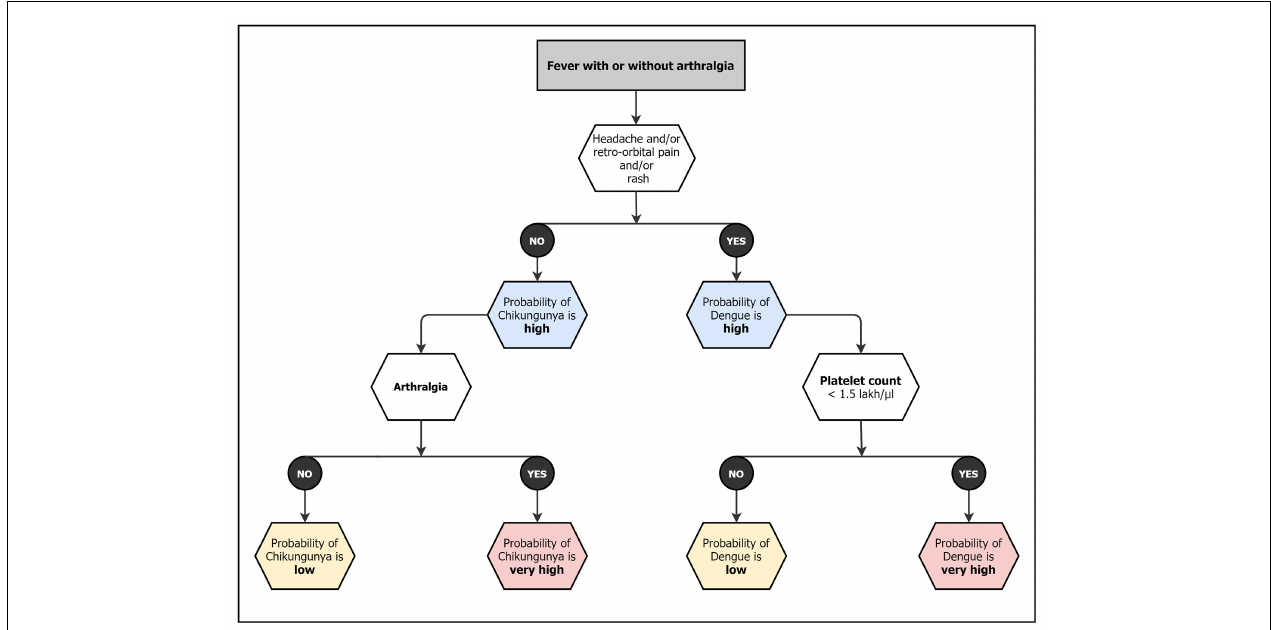
FIGURE 2 | Diagnostic matrix followed by Indian clinicians for CHIKF and related coinfections (Lee et al., 2012).